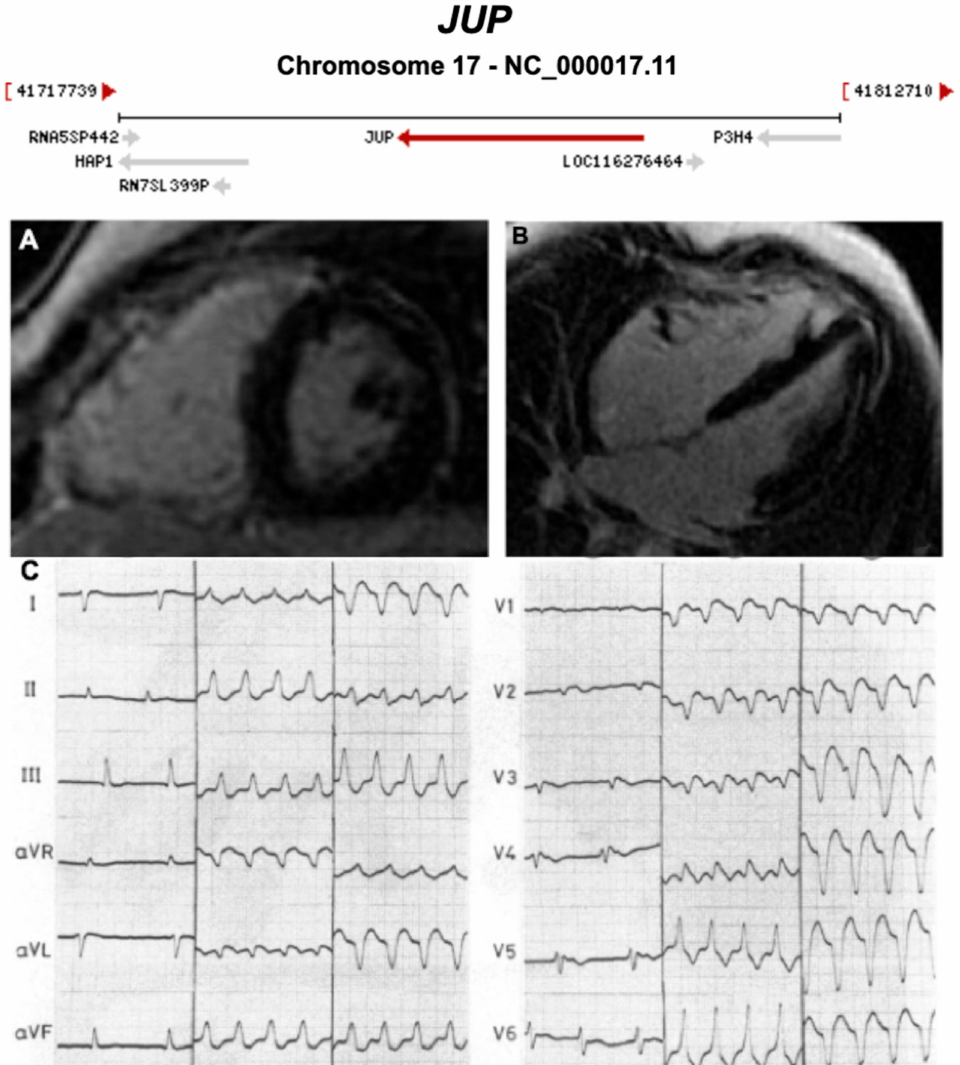
Figure 8. Exemplar MRI and ECG finding found in ACM patients with JUP mutations. ( A , B ) CMR of a patient with JUP mutation showing LGE of the RV free wall, secondary to fibrosis (white arrow); ( C ) ECG findings in a di ff erent patient with JUP mutation at 3 di ff erent times (separated by two vertical lines into 1. right panel = sinus rhythm with T waves inversion in V1–V6, and 2. middle and 3.left panels = ventricular tachycardia). ( A , B ) were reproduced with permission from Mavrogeni et al. (2012) [38]; ( C ) was reproduced with permission from Protonotarios et al. (1986)